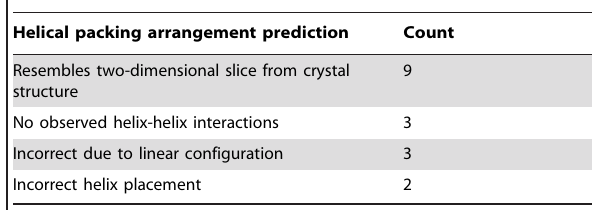
Table 5. Assessment of predicted helical packing arrangements for the 17 sequences where all interactions were successfully